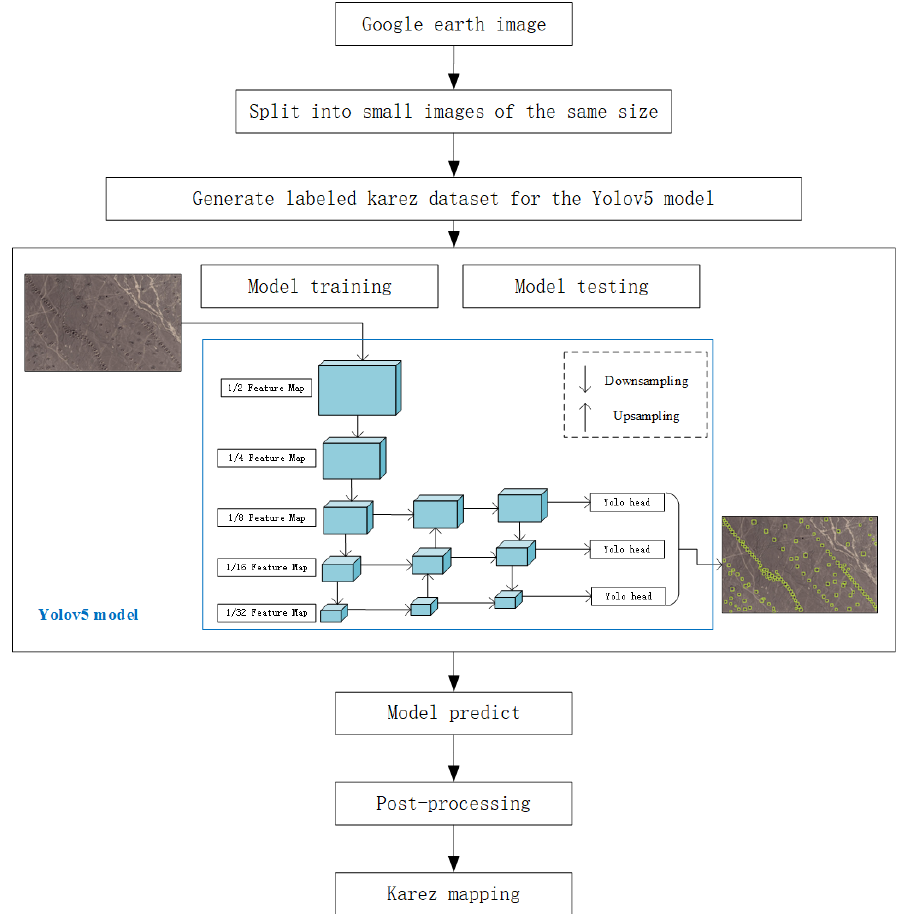
Figure 4. Automatic extraction roadmap for karez shaft based on Google and